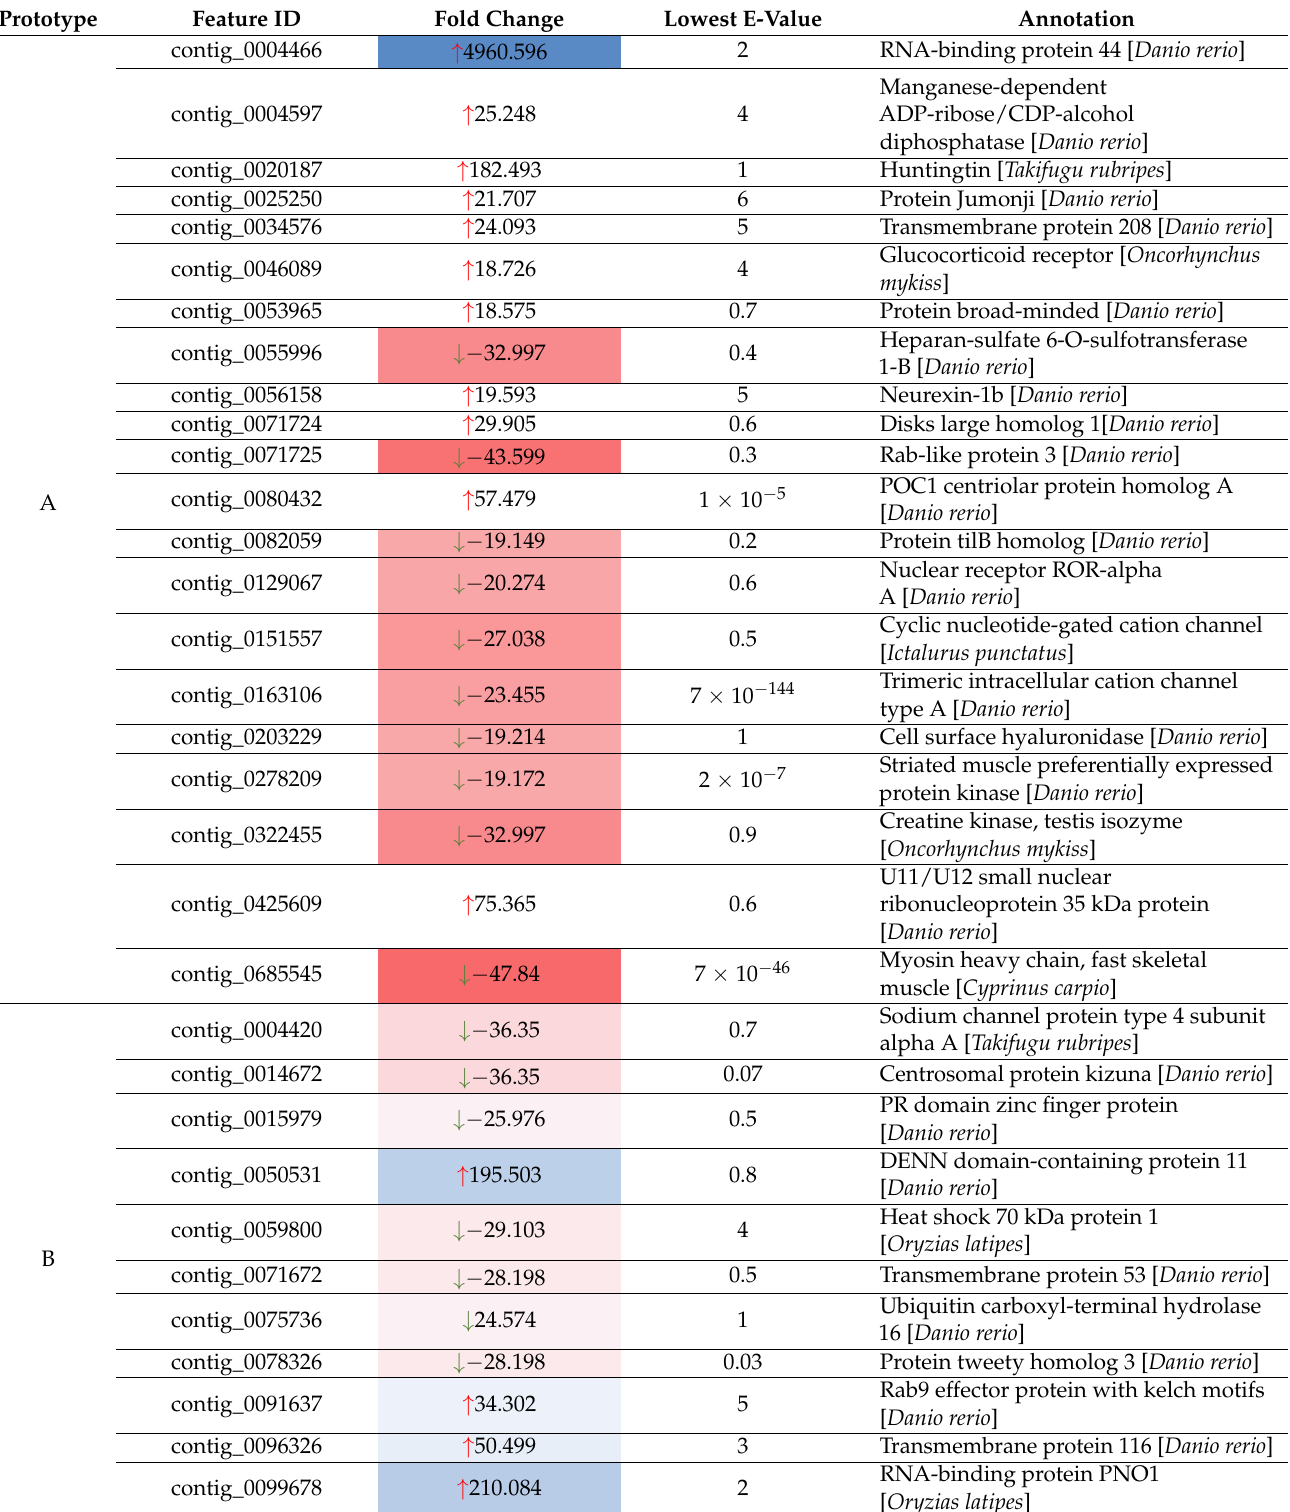
Table 1. Annotation of the differentially expressed contigs in head kidney tissue of vaccinated S. salar . Heatmap indicates the levels of regulation for each gene with blue at the top and red at the bottom. Red arrows indicate gene downregulation, and green arrows indicate